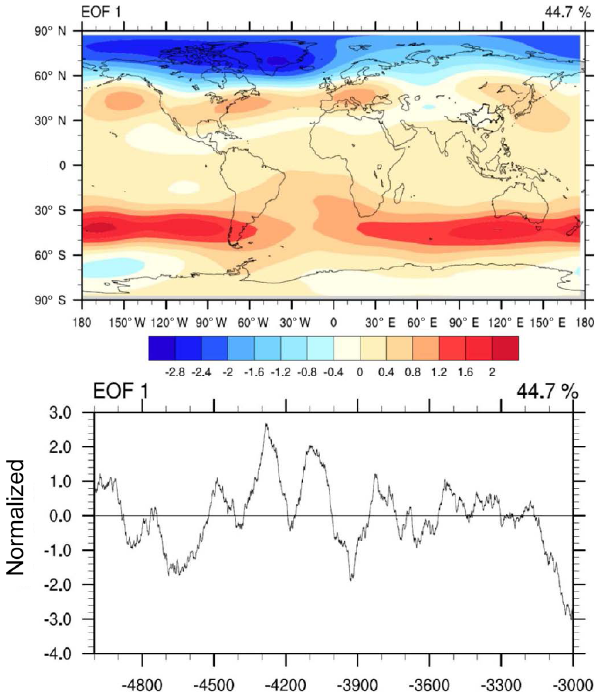
Figure 6. Standardized first leading mode of the EOF of annual mean SLP over the North Atlantic region (25–80 ◦ N, 70 ◦ W–40 ◦ E) during the period of 5.0 to 3.0ka derived from the TraCE-ALL run, after the application of a 101-year running mean. The spatial distri- bution is shown in the top panel, and the time series is shown in the bottom panel. Only this mode passed the North test for the EOF.